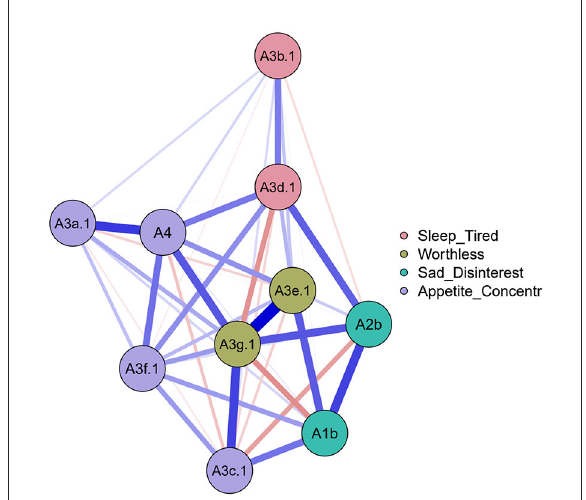
FIGURE3 Regularized networks of the depression items colored by facets (before collapsing).